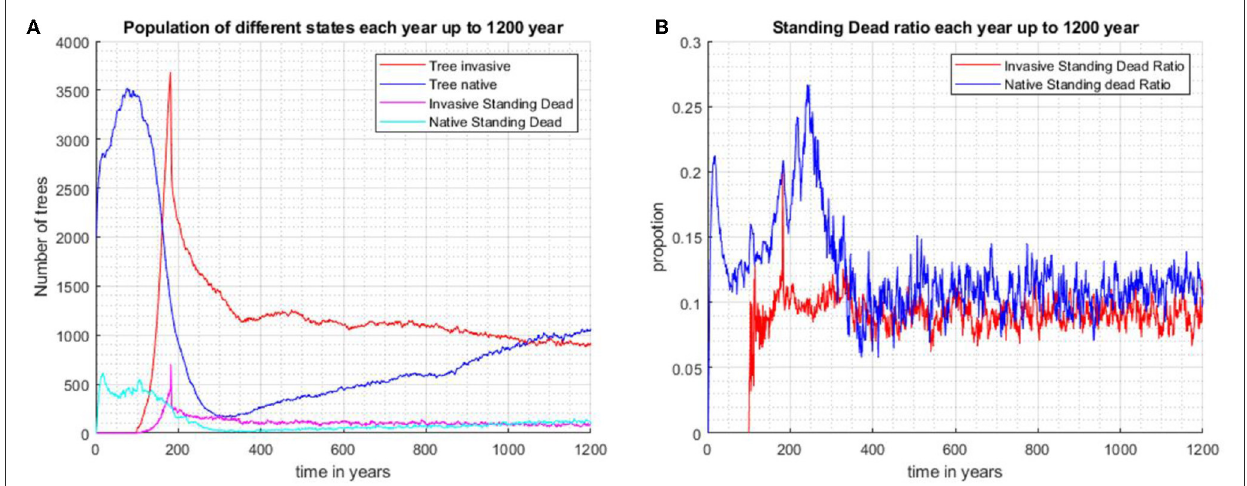
FIGURE6 The native species is first allowed to run for 100 years before the invader is introduced as 100 randomly scattered individuals (Scenario 4). Biocontrol is introduced after 180 years. The invasive species is under control and the vegetation is mostly dominated by the increasing population of native species after 1,200 years. (A) Population number for invasive trees, native trees, invasive standing stand stems, and native standing dead stems. (B) Proportions of standing dead and the total population of each species.